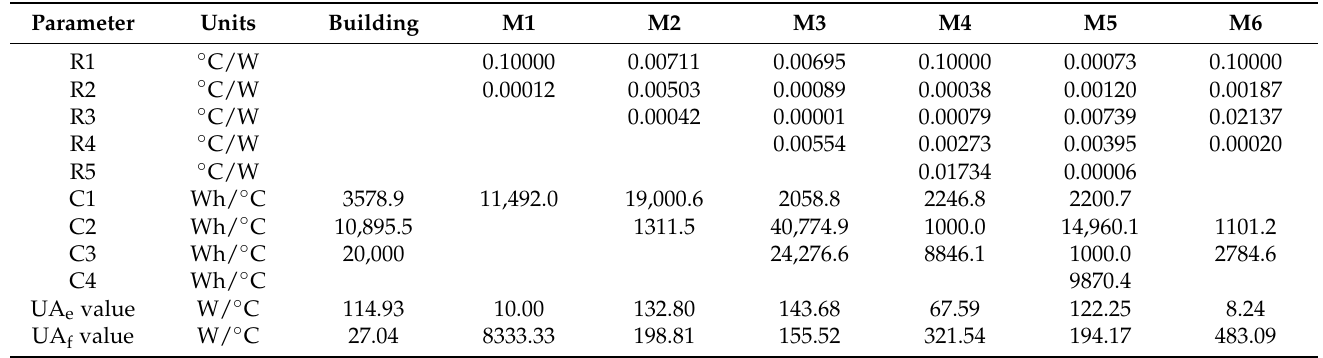
Table 6. Identified parameters and calculated UA value of each model for the real